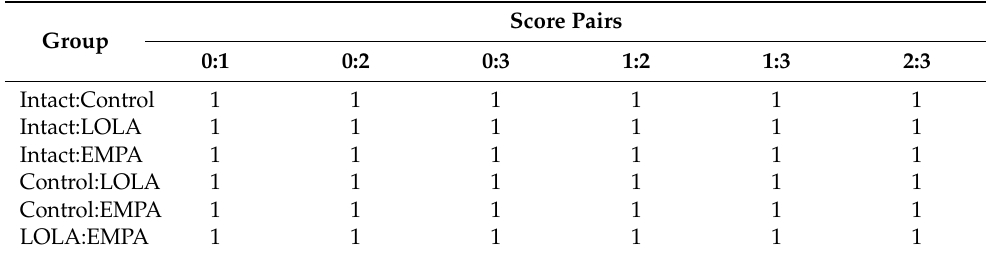
Table A2. Adjusted p -values for steatosis score frequency